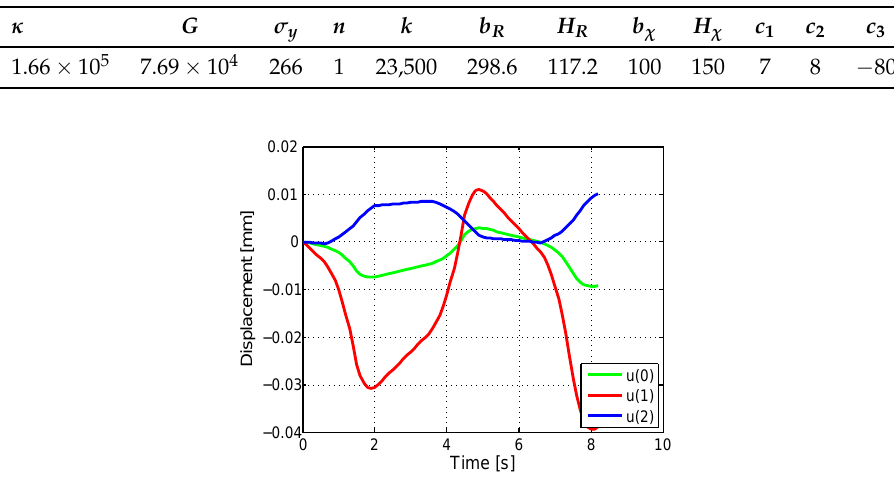
Table 4. The model parameters.